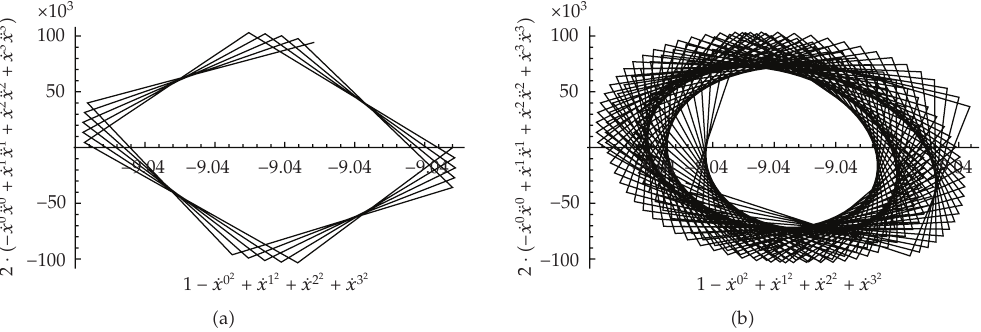
Figure 14: The cycling orbit filling the oval frame and the beginning of its propagation. Time step: 10 − 11 GeV − 1 . The scale is about 6 times smaller than the one in Figures 13 (cid:6) a (cid:7) and 13 (cid:6) b (cid:7)